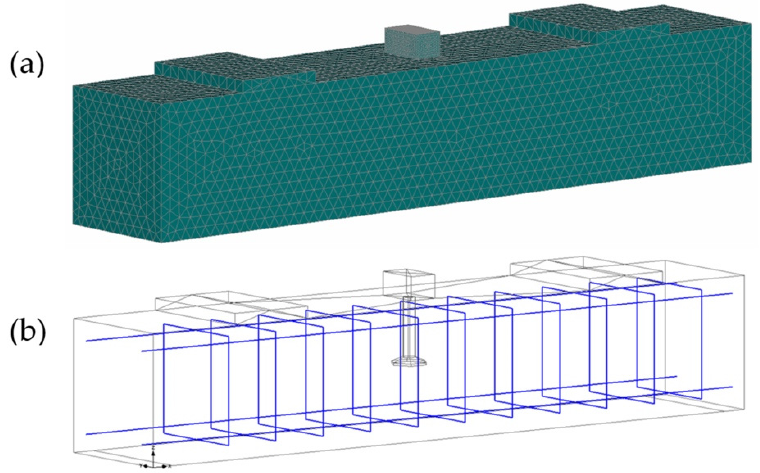
Figure 9. Numerical model: ( a ) macroelements with mesh; ( b ) longitudinal and shear reinforcement—1D elements.